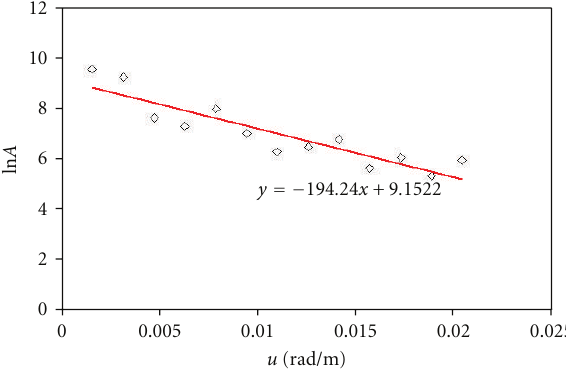
Figure 11: The linear part of natural logarithm of the amplitude spectrum against spatial frequency u